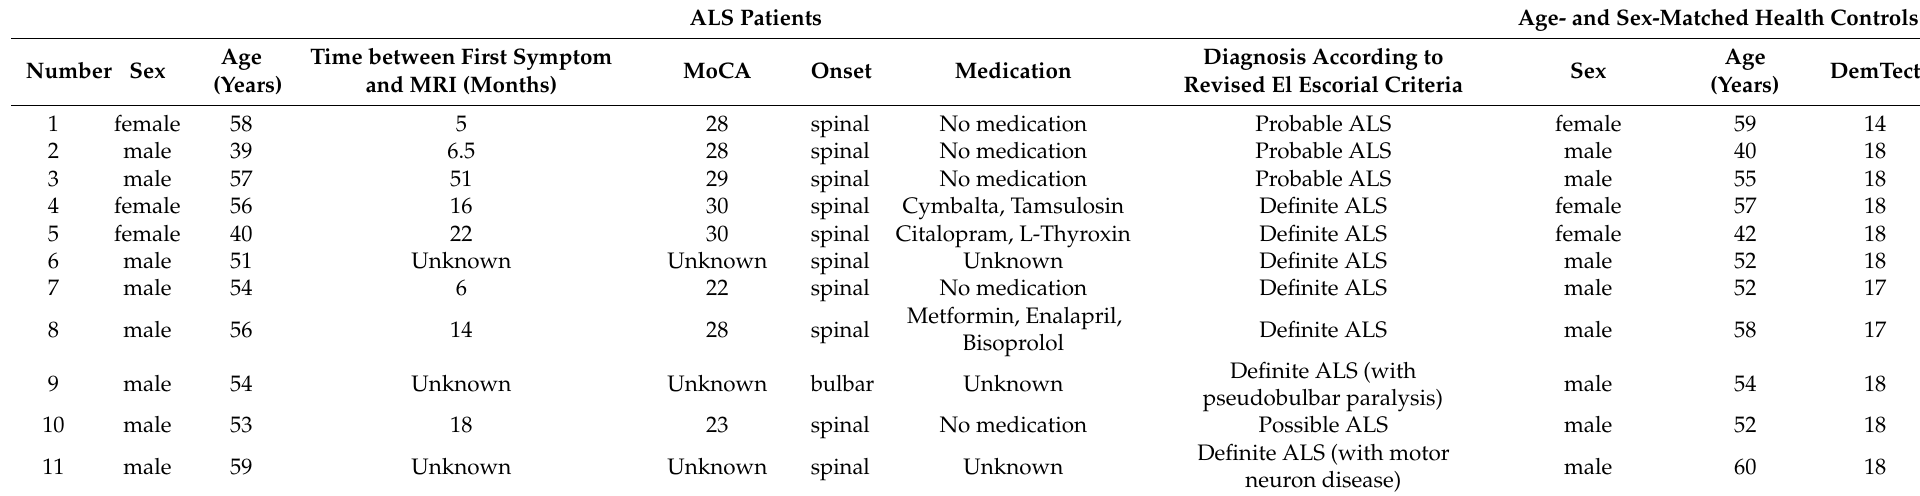
Table 3. Characteristics of the ALS patients and age- and sex-matched health